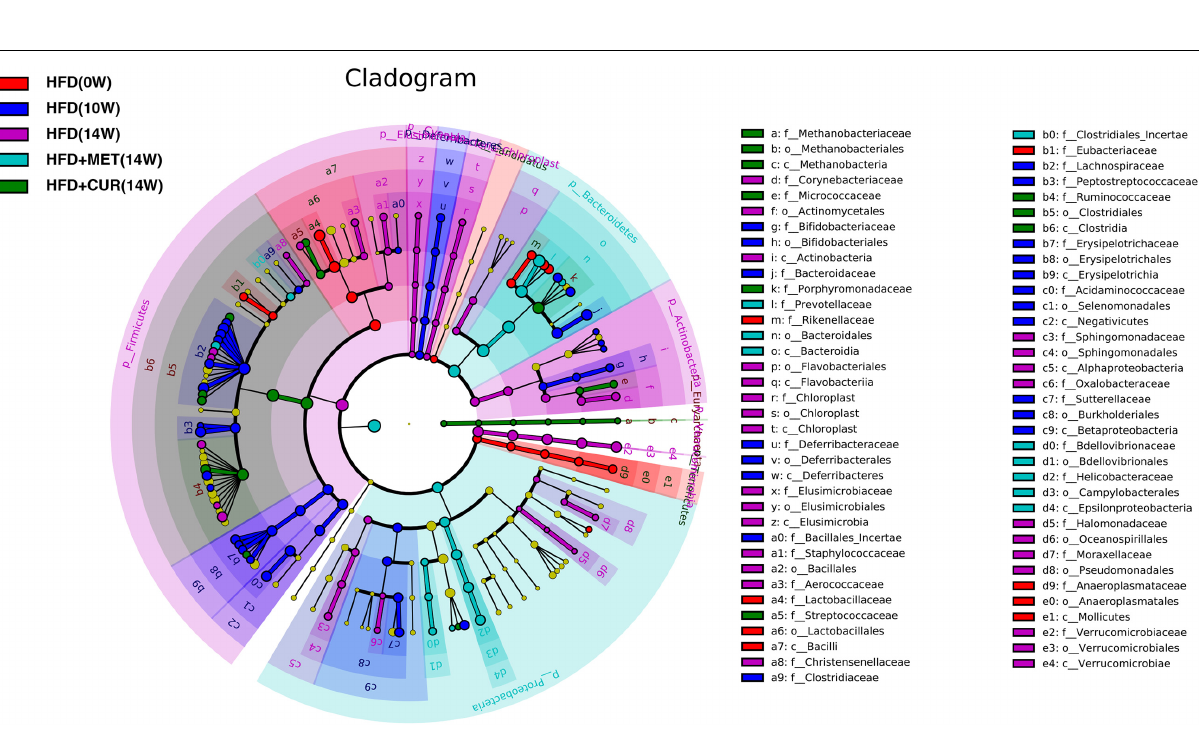
Frontiers in Microbiology |